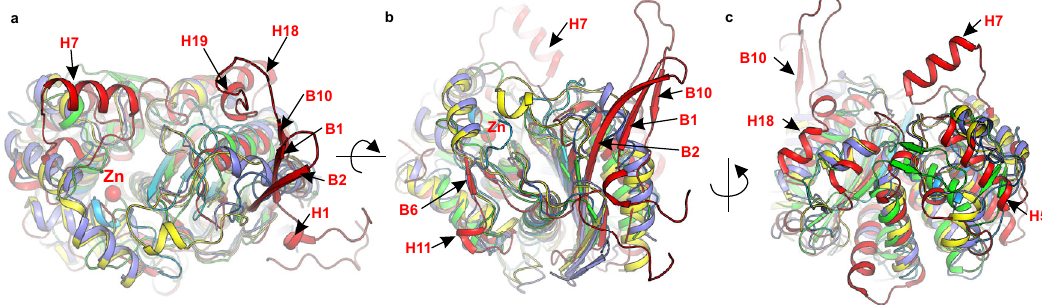
Fig. 7 Superposition of ReAV (red) and selected proteins with detectable structural similarity (identi fi ed by their PDB codes and color). E. coli glutaminase (yellow, 1u60), B. subtilis glutaminase (violet; 1mki), human liver-type glutaminase (cyan, 4bqm); L. monocytogenes PBP (green, 5zqe). Panels a , b , c show the same superposition in different orientations. The central β -sheet and helices in the protein core superpose quite well, while the most important differences are visible for strands B1, B2, B10 and helix H7. Structural elements that differentiate ReAV from the other proteins are indicated by arrows. The red sphere marks the zinc ion coordinated in the ReAV active